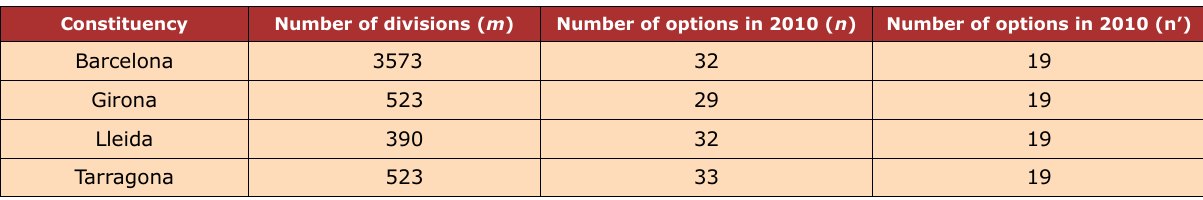
Table 1. Sizes of the data sets used in the computational experiment. In all cases, the number of options includes null and blank votes and